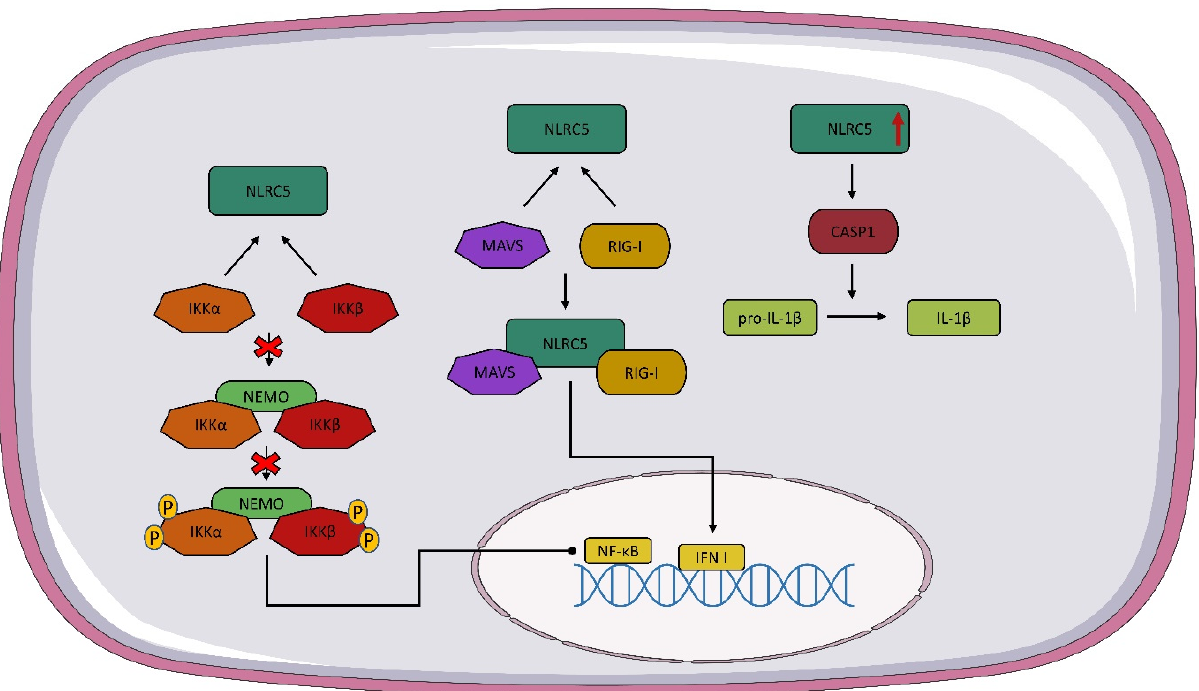
Figure 2. NLRC5 signaling pathway . As a result of the interaction of NOD-like receptor C5 NLRC5 with I κ B kinase alpha/beta (IKK α / β ), the NEMO IKK α / β complex is not formed and nuclear factor kappa B (NF- κ B) expression is stopped. The interaction of NLRC5 with mitochondrial antiviral signaling protein (MAVS) and RIG-I leads to the formation of a complex of NLRC5 plus MAVS and RIG-I, which contributes to the expression of IFN I. Overexpression of NLCR5 activates caspase 1 (CASP1), which converts pro-IL-1 β to active IL-1 β .